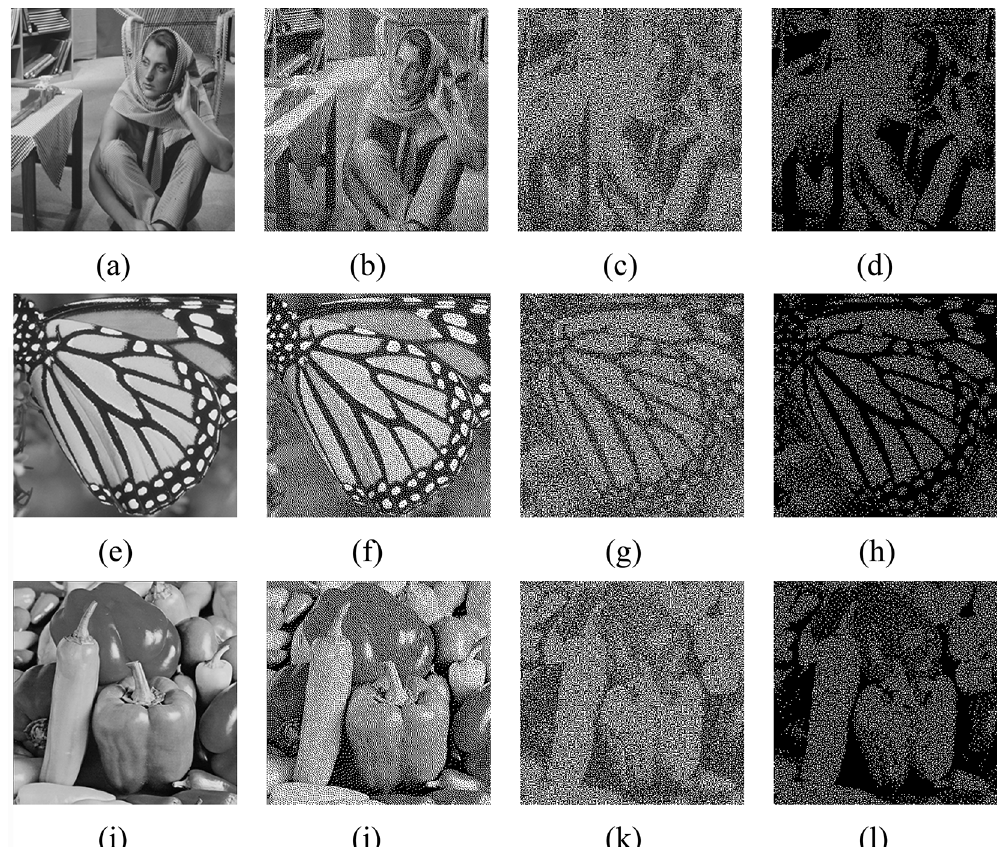
Figure 2. Experimental results of halftone images. Columns are original gray-scale images, halftone images generated by the ER method, halftone images generated by two thresholds, respectively. All the size is 512 × 512